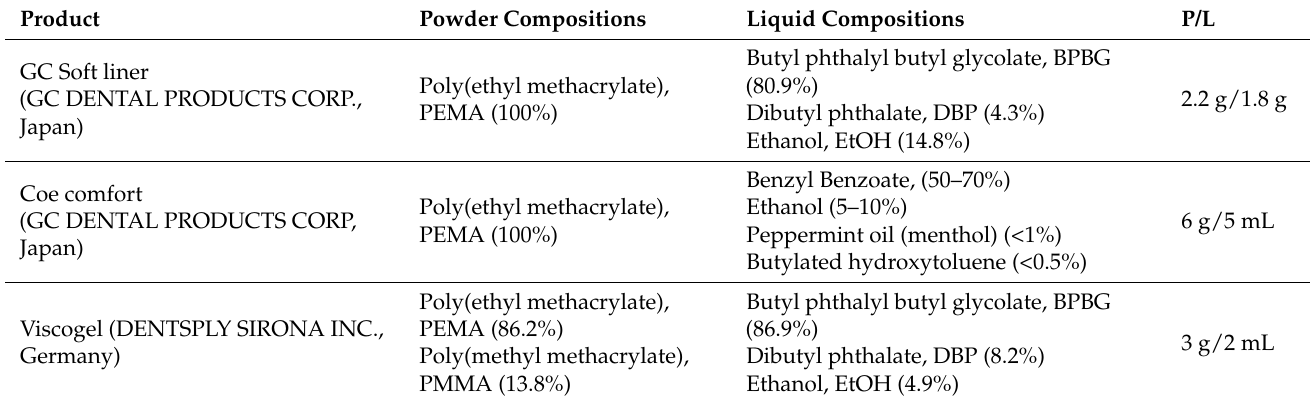
Table 1. Chemical compositions of soft lining materials used in this